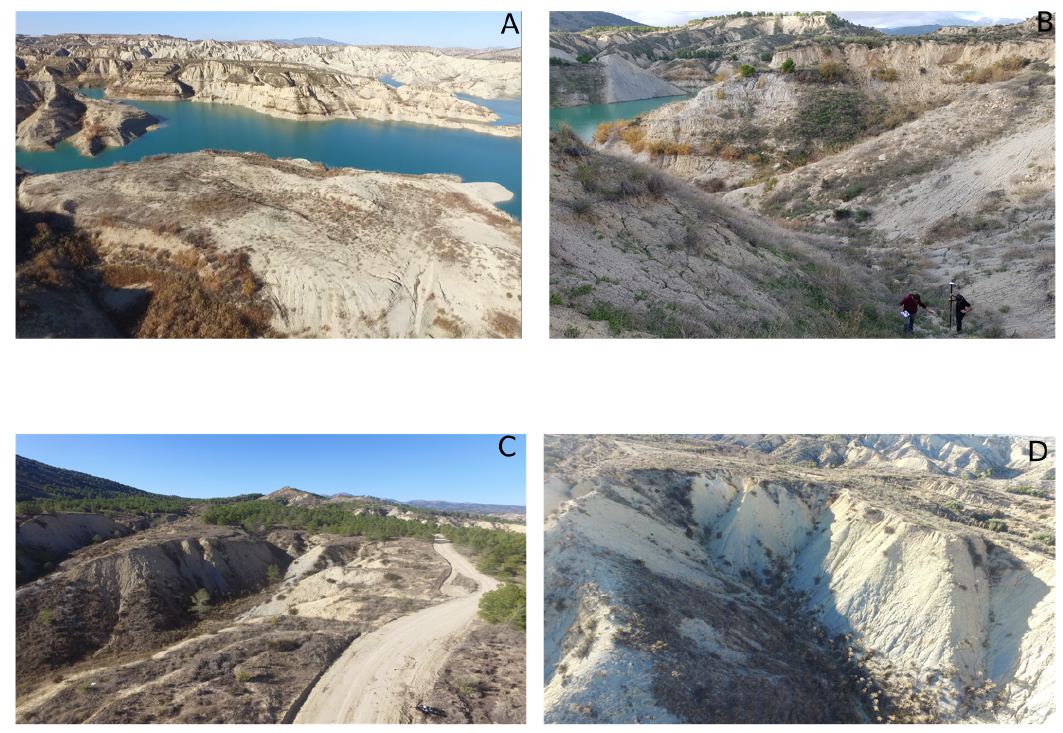
Figure 2. Photos of the lakeshore of Rambla de Algeciras. ( A ) Lakeshore. ( B ) Third bank gully. ( C ) Bank gully (B.G.-1). ( D ) Second bank